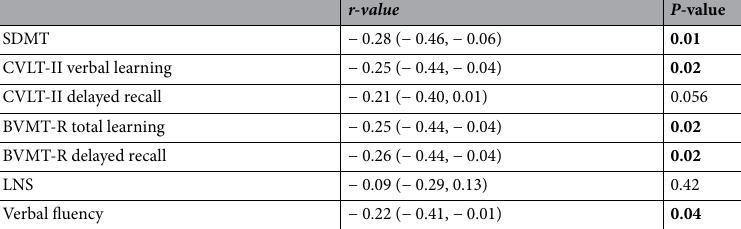
Table 4. Spearman correlation coefficients (95% confidence intervals) between FRS and cognitive functioning z-scores. Significant values are in bold. SDMT Symbol Digit Modalities Test, CVLT-II California Verbal Learning Test-II, BVMT-R Brief Visuospatial Memory Test-Revised, LNS Letter-Number Sequencing